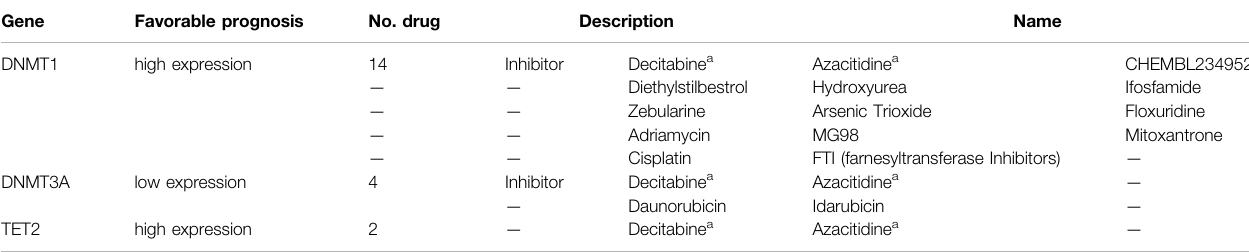
TABLE 1 | Emphasis on 5mC regulators and corresponding